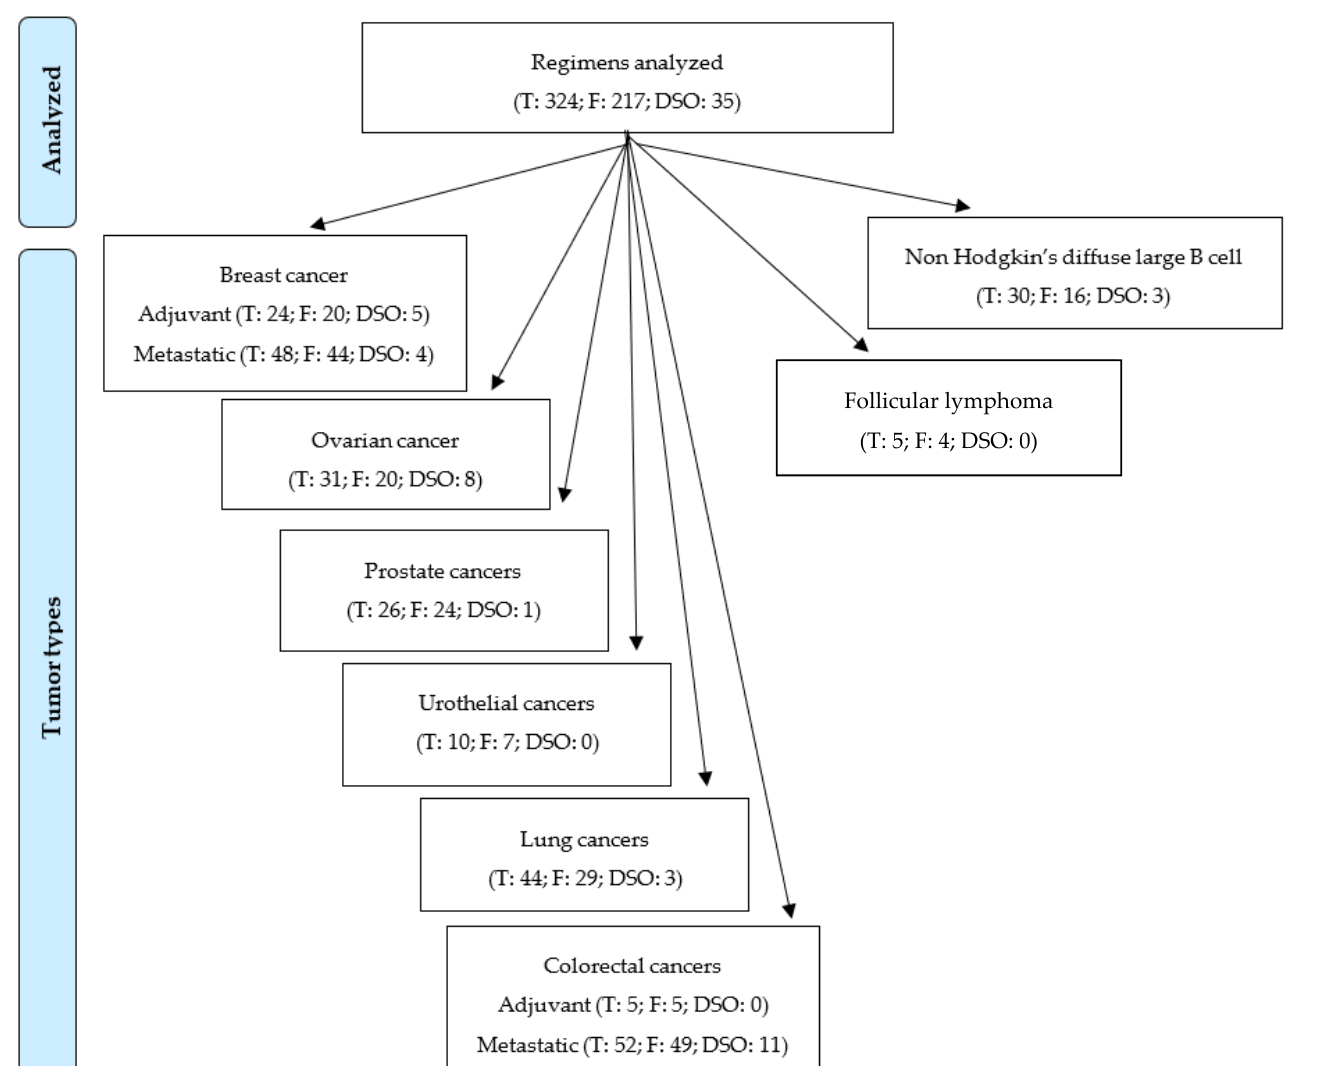
Figure 2. Flowchart detailing for each cancer type, indicating the total (T) number of regimens analyzed, the number of regimens for which fatigue (F) was reported, and the number including data specific to older adults (DSO).